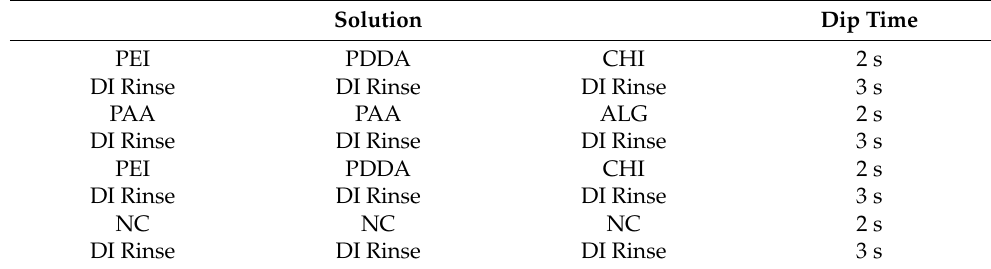
Table 1. Coating sequences for microscopic glass slides using the customised dipping robot.